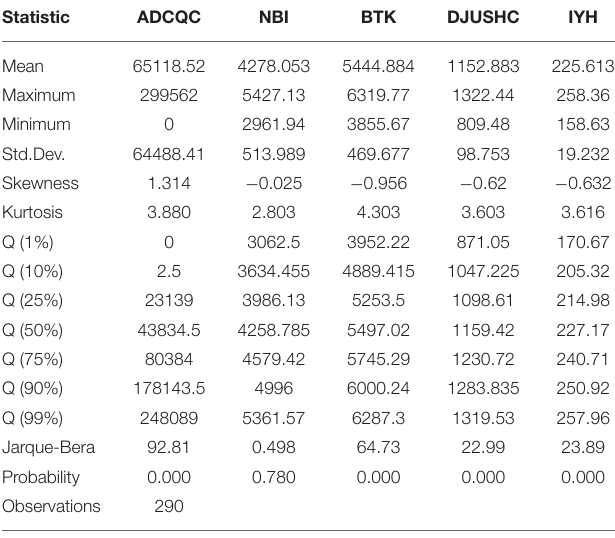
TABLE 3 | Descriptive statistics.